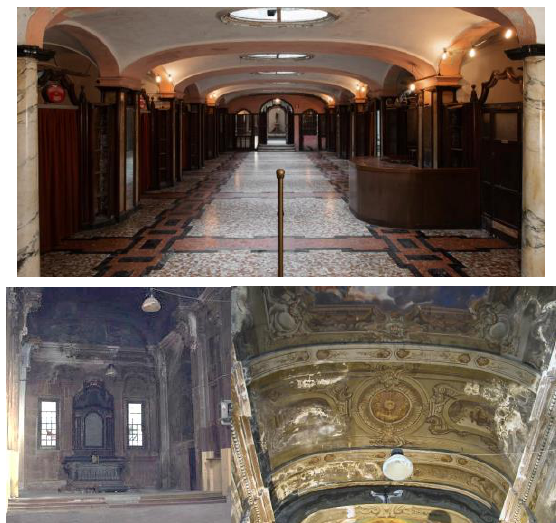
Figure 7. The case studies: Albergo Diurno (top) and Church of S. Vittore